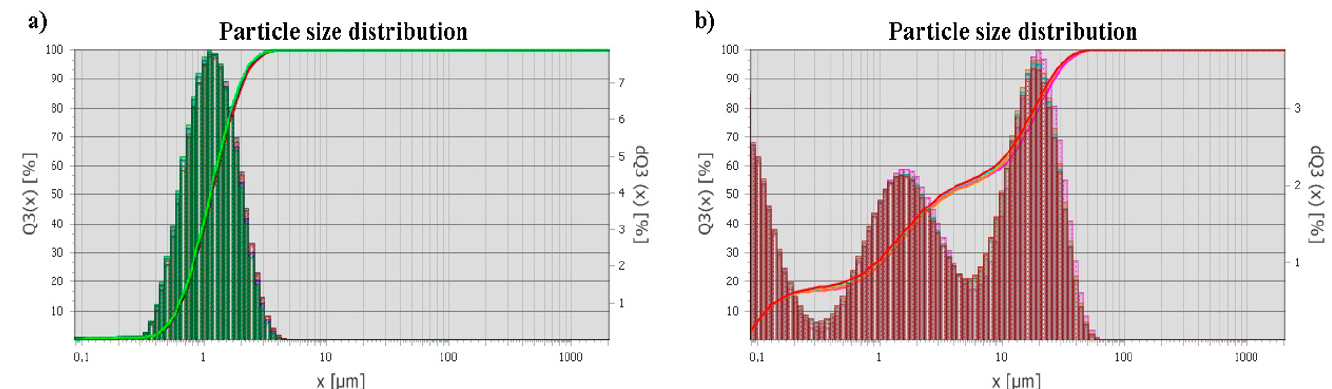
Figure 2. SEM images of F-BaTiO 3 powder at different magnifications: general view ( a ), powder particles ( b ).